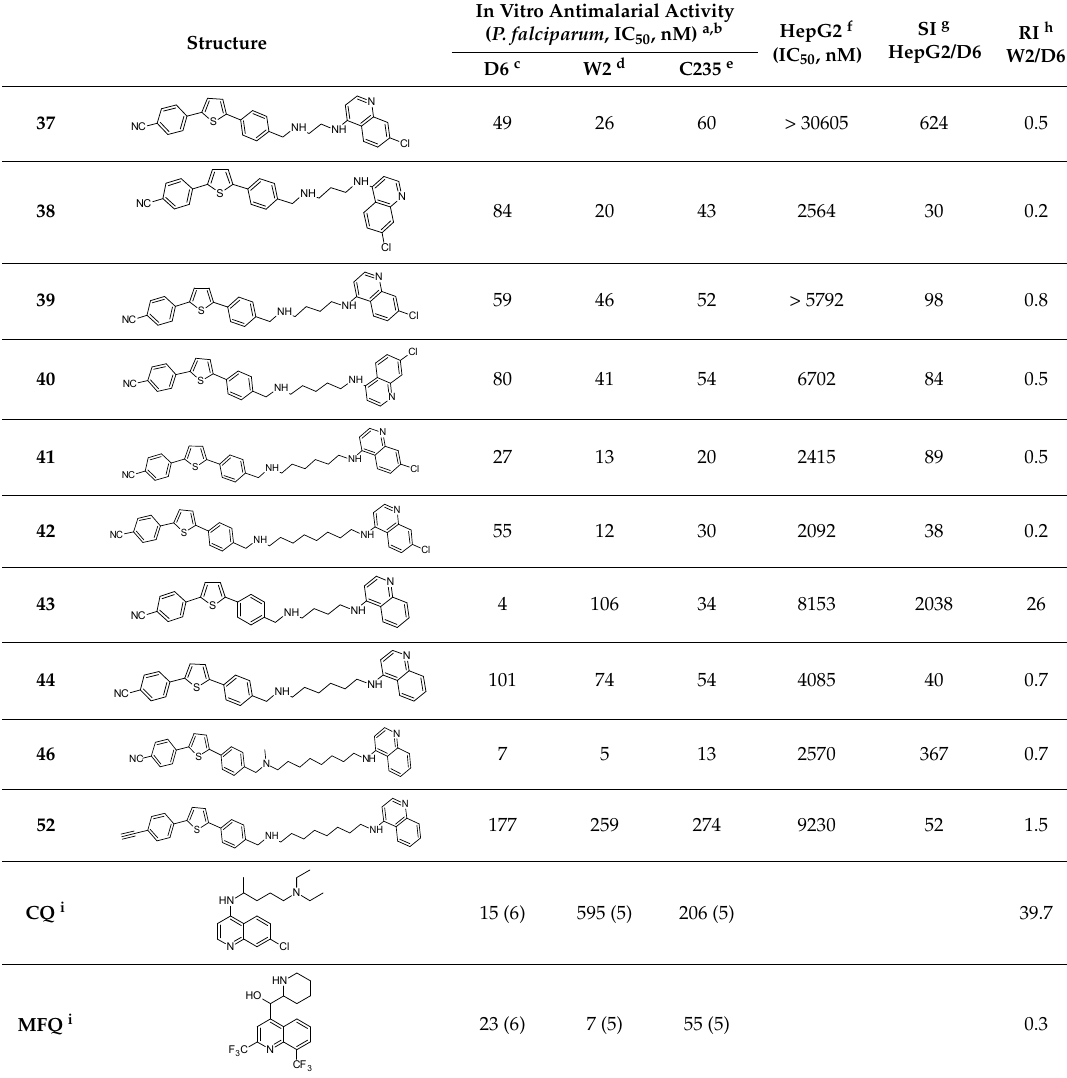
Table 2. In vitro antiplasmodial activity of thiophene derivatives. Structure